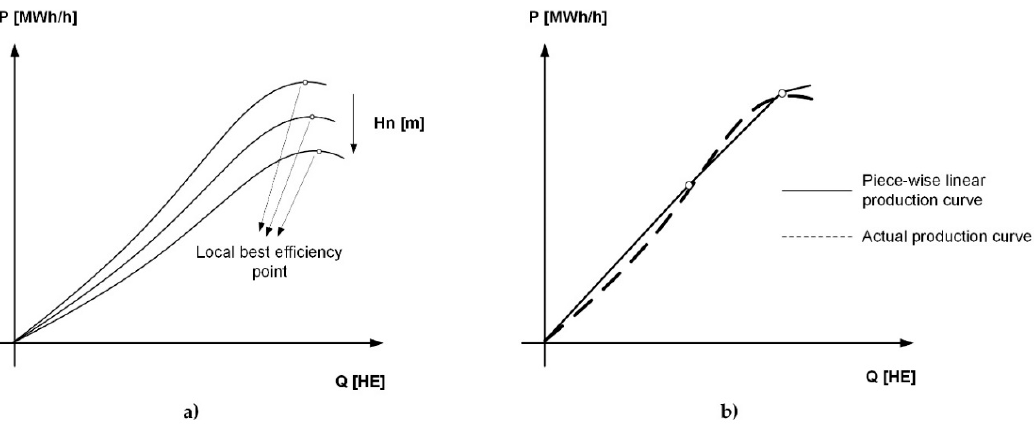
Figure 3. Discharge characteristics of hydropower plant. ( a ) Original discharge characteristic of the hydropower plant; ( b ) piece-wise linearized discharge characteristic with neglected variable head. H n : net head in m; P: output electrical power of HPP in MW; Q: discharge of water through the HPP turbine in HE; HE: hour